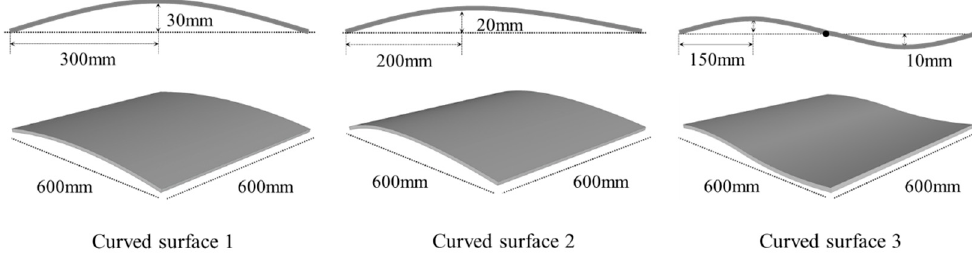
Figure 7. Design of the curved surfaces tested. All the curved surfaces were designed to have a single curve, so the set heights of rods X 1 to X 6 were the same; the values of X and Y 1 to Y 6 to produce the correct curved surface are shown in Table 1. X a is the height that would be set for a rod without joints and X b is height set for rods with joints. For curve 1, the Y value of X a was measured in the range from 9.2 mm to 29.2 mm and X b was measured in the range from 8.5 mm to 29.1 mm. For curve 2, the Y value of X a was measured in the range from 8.7 mm to 40.9 mm and X b was measured in the range from 7.9 mm to 40.9 mm. For curve 3, the Y value of X a was measured in the range from 1.6 mm to 19.6 mm and X b was measured in the range from 1.4 mm to 19.5 mm. The difference in the heights set (X a-b ) according to the existence of joints in the three types of curve shapes fell in the range from 0.0 mm to 2.0 mm. This difference was very small, but the precise input values were important to match the design as closely as possible, i.e., X b were used to minimize shape errors. Table 1. Set heights of rods according to the existence of joints (unit: mm). Curved Surface 1 Y 1 Y